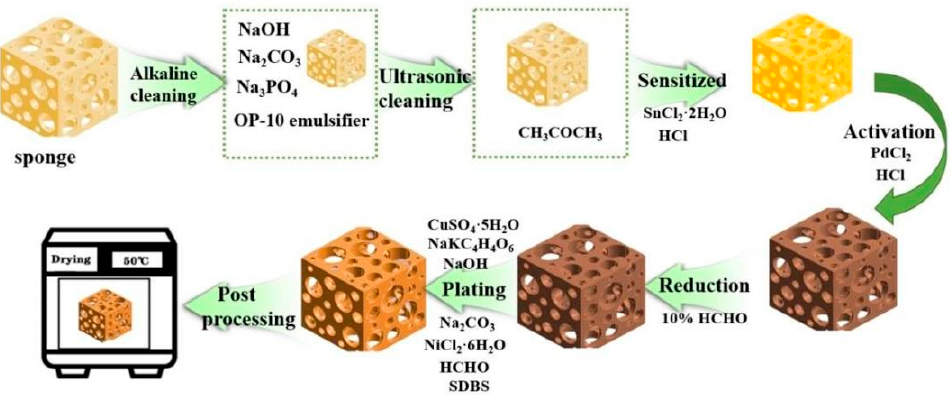
Figure 1. Schematic diagram of the flexible piezoresistive sensor preparation